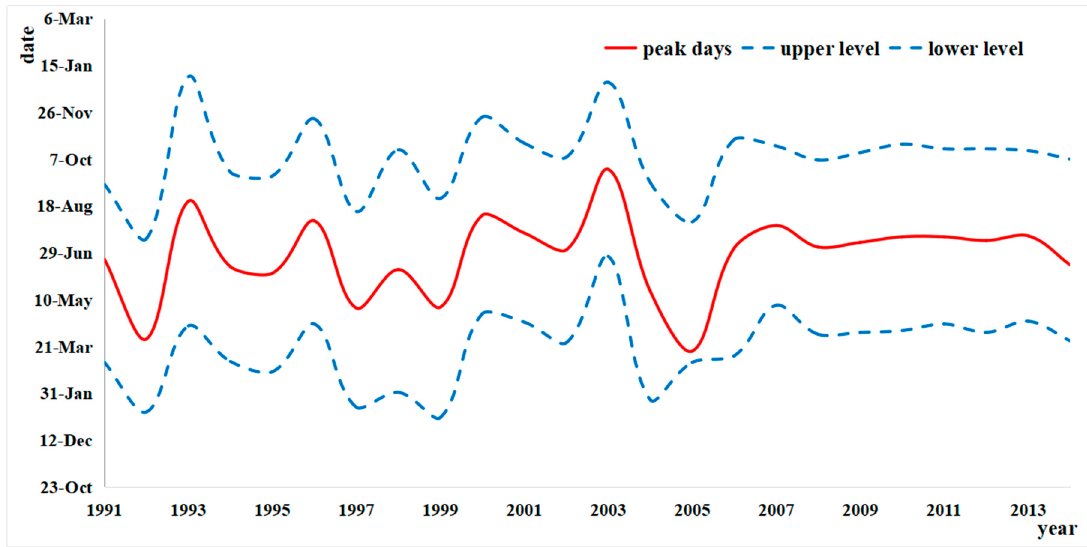
Figure 6. Peak days of typhoid and paratyphoid in Zhejiang from 1991 to 2014 (The peak days, the upper level, and lower level may occur in another year, so the y-axis concludes three years).